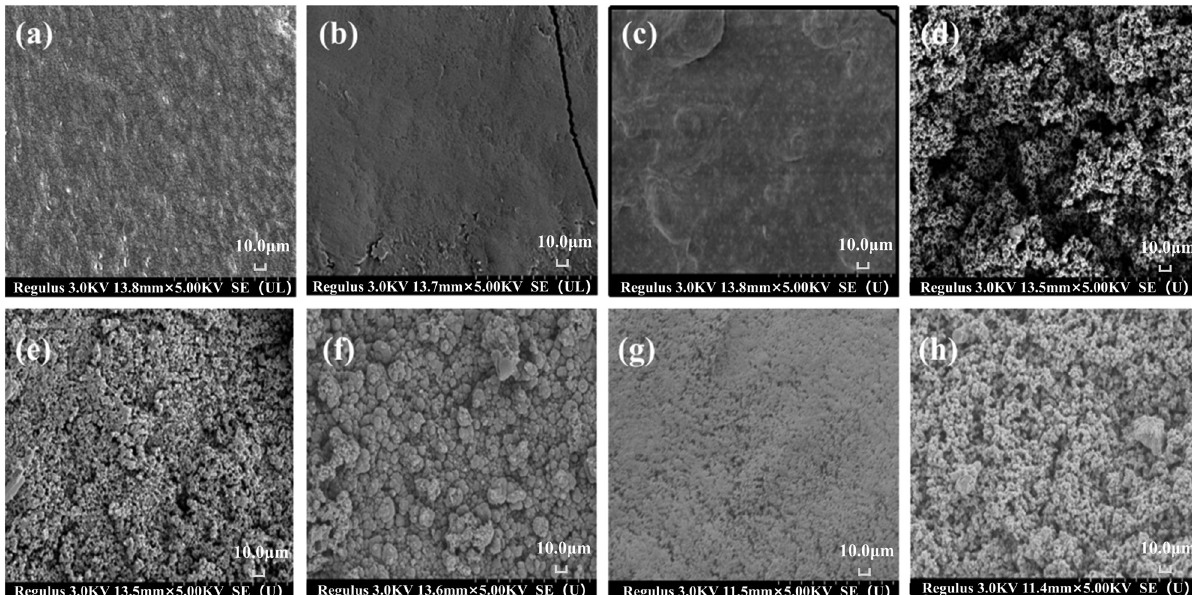
Figure 3: SEM image of ( a ) pure SF and ( h ) pure PEDOT. ( b – g ) The surface morphology of SF/PEDOT membranes prepared at 0.5, 1, 2, 4, 8, and 16 h,